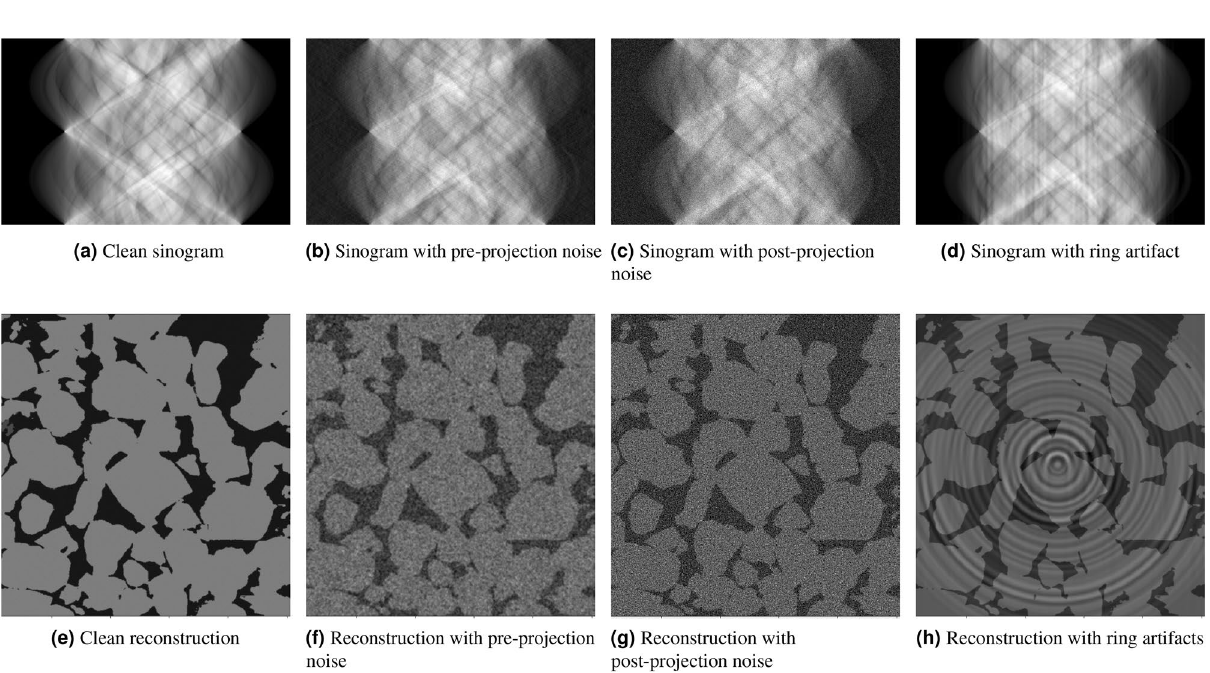
Figure 3. An illustration of different types of noise at the projection step (sinograms) and after the reconstruction step (micro-CT images). The ring artifacts appear as vertical stripes in the sinogram domain ( d